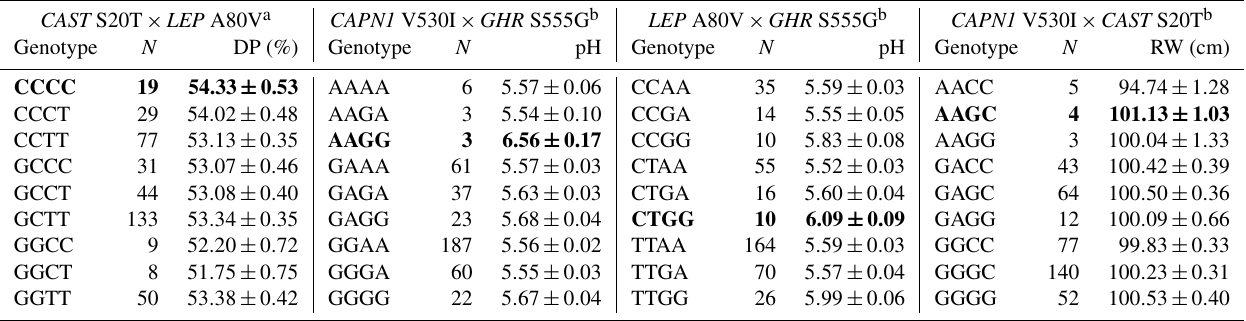
Table 5. Least-squares means, and standard errors for the significant associations of genotypic interactions with related traits in a Holstein population ( N =